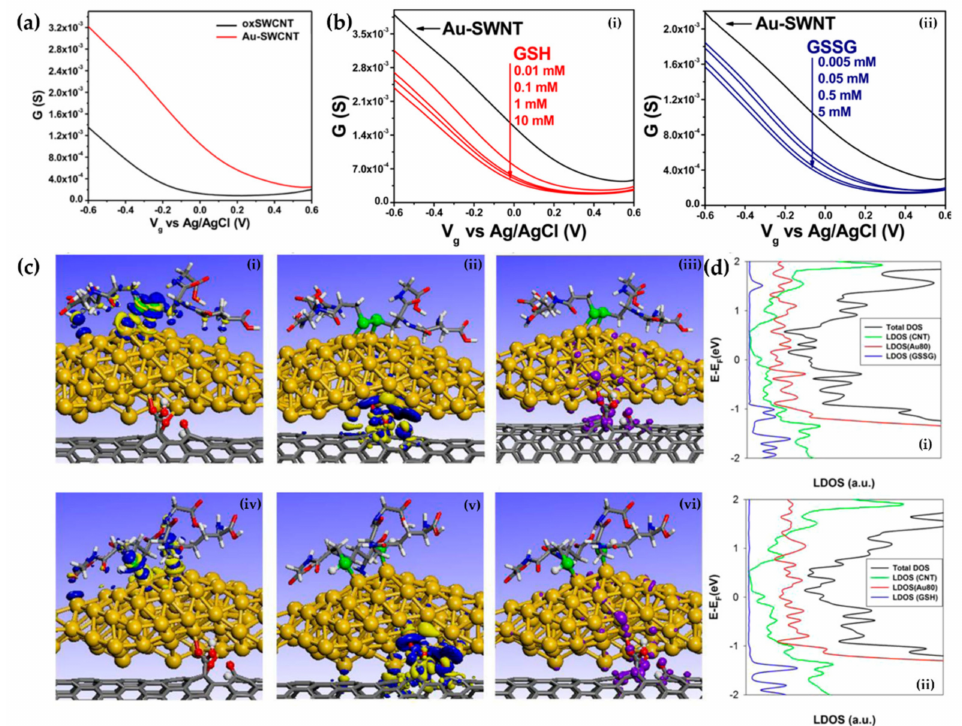
Figure 3. Field-effect transistor based on single-walled carbon nanotube (SWCNT) decorated with Au nanoparticles (NPs) for the detection of GSH and GSSG. ( a ) Transfer characteristics (I DS vs. V GS ) for the SWCNTs before and after the electrodeposition of Au NPs and ( b ) for the detection of reduced glutathione (GSH) ( i ) and oxidized glutathione (GSSG) ( ii ). ( c ) Results of density functional theory calculations for two representative adsorption configurations of GSSG and GSH on the hybrid Au80-(14,0) SWCNT system. Panels ( i ) and ( iv ) represent the charge difference maps for GSSG and GSH at the interface between the molecules and the Au nanocluster. Panels ( ii ) and ( v ) show the charge difference maps at the interface between the Au nanocluster and the SWCNT. Panels ( iii ) and ( vi ) show the partial charge density (isovalue of 0.01 e − /Å 3 ) corresponding to the electronic bands within a 0.2 eV interval above the Fermi level. ( d ) Total density of states and the local density of states of SWCNT, Au cluster, and the individual GSSG ( i ) or GSH ( ii ) molecules. Adapted from [115] with permission from